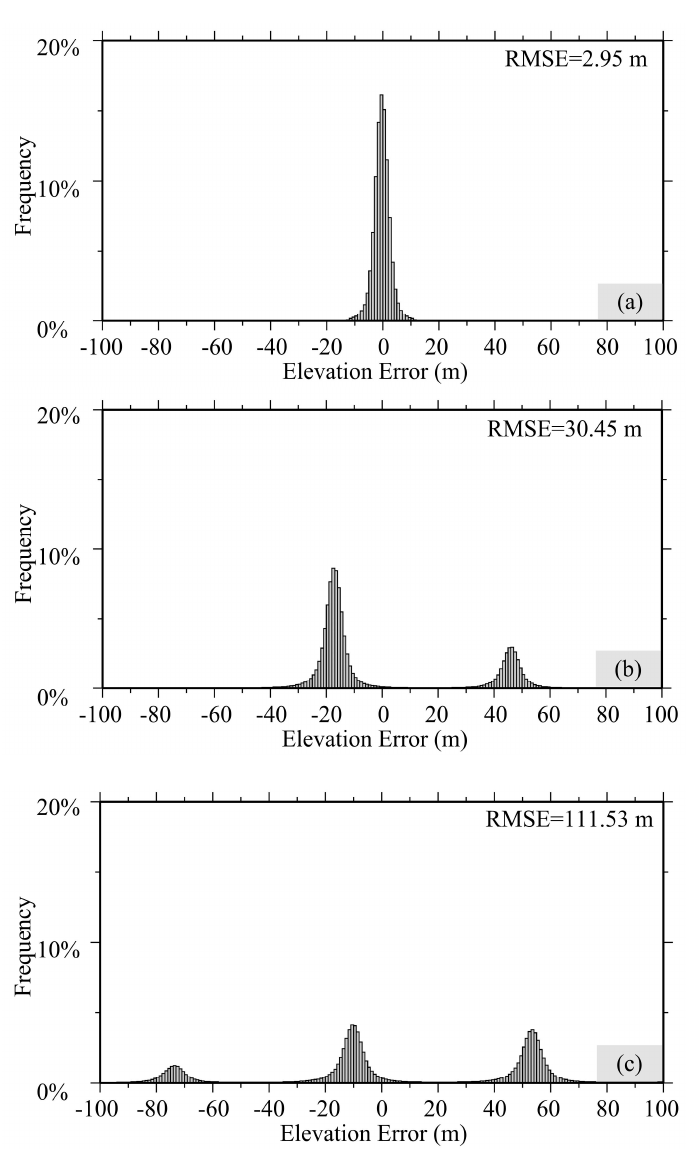
Figure 8. ( a – c ) Histogram of elevation error. In ( a – c ) the simulated elevation differences are 2000 m, 2600 m, 3000 m, respectively.